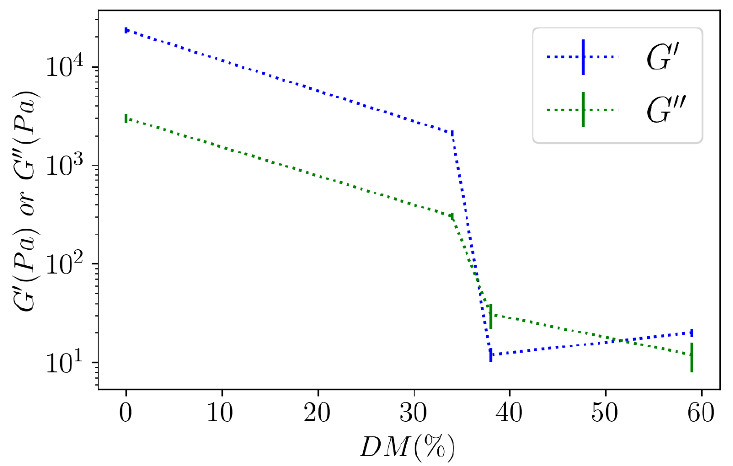
Figure 10. The effect of DM on the viscoelastic behavior on values of G′ and G ″ as a function of DM of Araçá pectins. From DM = 40% to 30%, G′ passes from 10 1 to 10 4 Pa, thus, showing that the formation